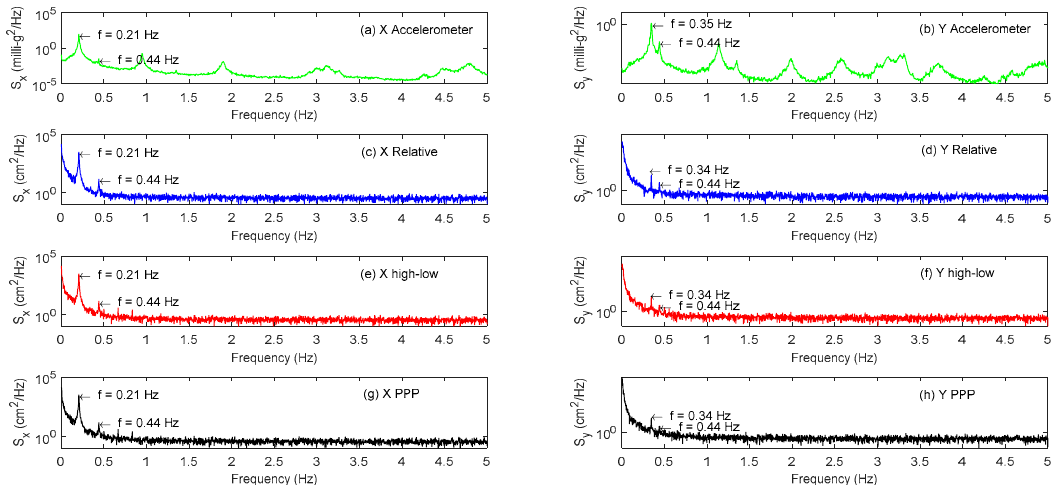
Figure 9. Spectrum analysis of GPS and accelerometer observation sequence: ( a ) X direction acceleration data; ( b ) Y direction acceleration data; ( c ) X direction relative positioning method; ( d ) Y direction relative positioning method; ( e ) X direction combining high- and low-rate GPS method; ( f ) Y direction combining high- and low-rate GPS method; ( g ) X direction PPP method; and ( h ) Y direction PPP method.